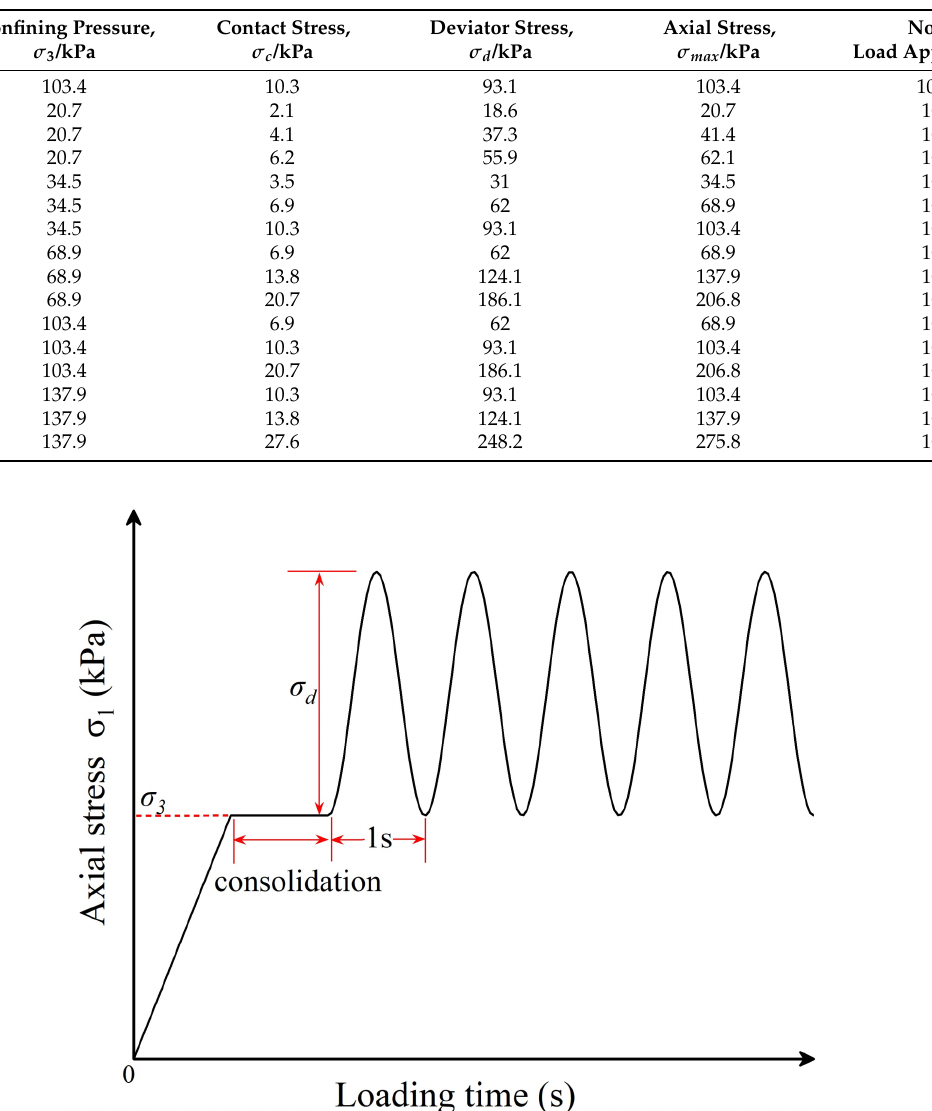
Table 4. Loading sequences of the resilient modulus tests of recycled BDW aggregates.